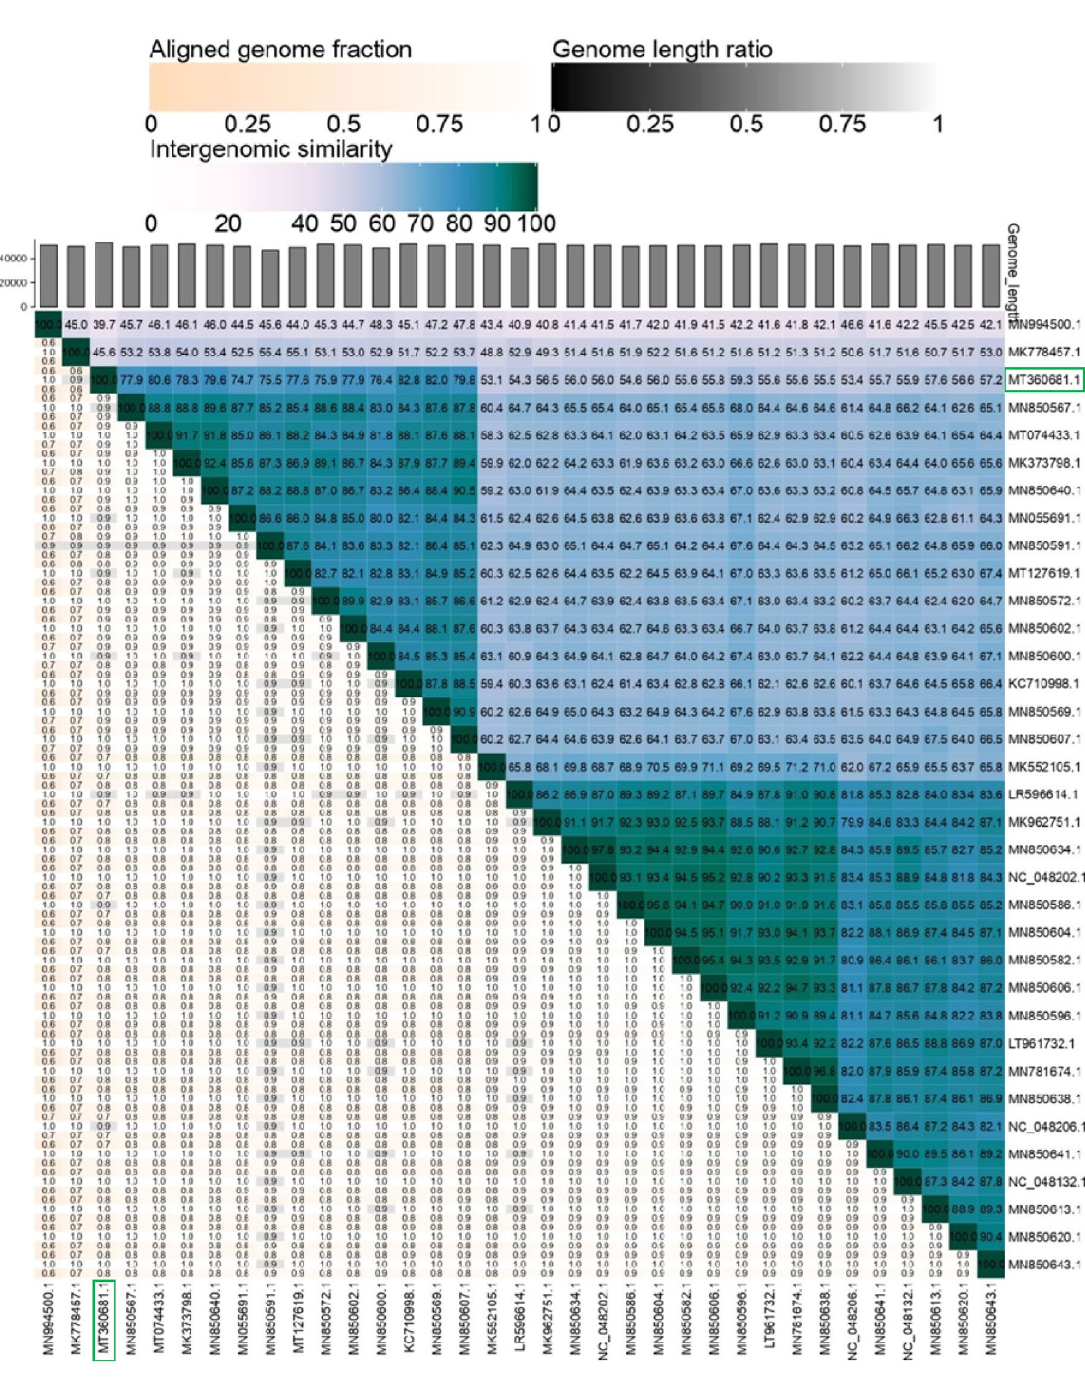
Figure 6. Heat map showing whole genome comparison of Shigella virus 2019SD1 with 34 other members of Drexlerviridae . Heat map was generated using VIRIDIC server with the threshold set to 95% for species